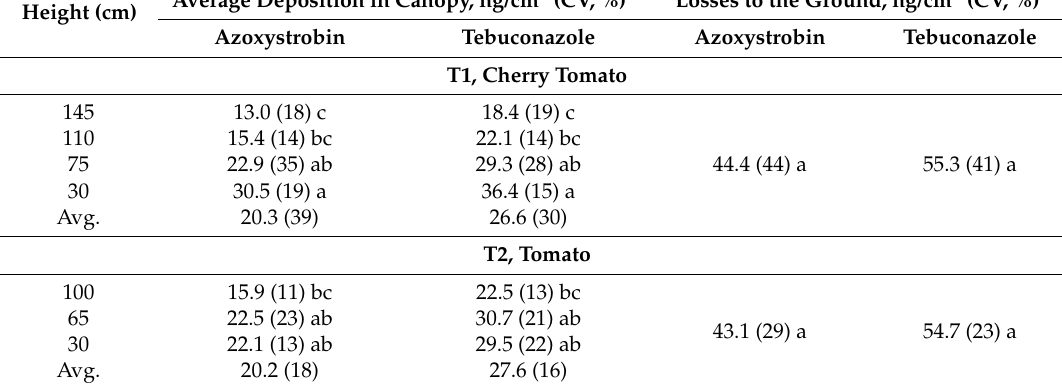
Table 3. Average depositions and coefficients of variation for deposition per unit filter paper in the canopy and losses to the ground.